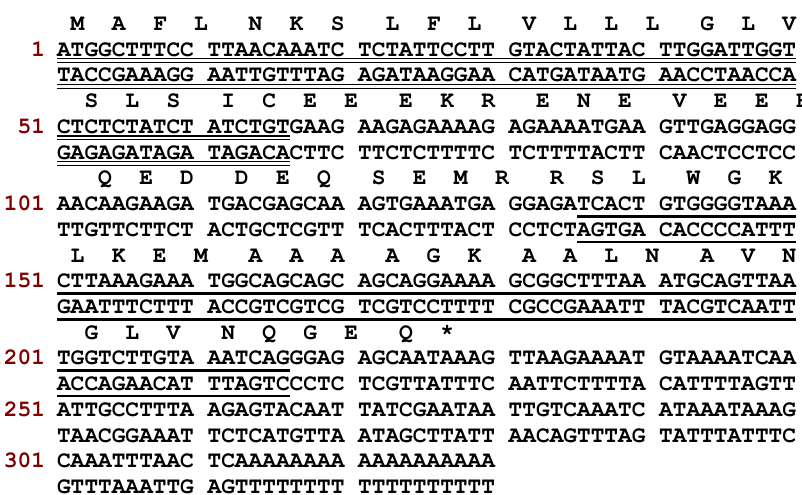
Figure 1. Nucleotide sequence of cloned cDNA encoding the biosynthetic precursor of DRP-AC4 from A. callidryas and translated amino acid sequence of the open reading frame. The putative signal peptide is double underlined, the mature peptide is single underlined and the stop codon is indicated by an asterisk.